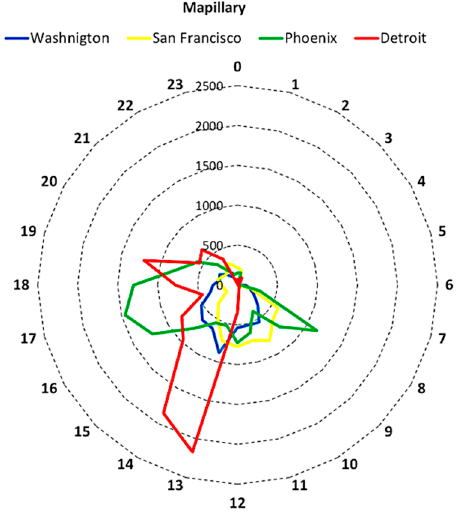
Figure 11. The distribution of user contributions over a span of twenty-four hours in Mapillary.